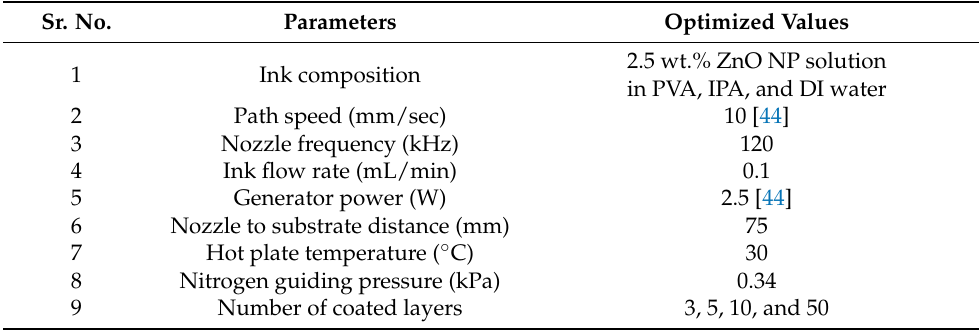
Table 1. The optimized parameters of the ultrasonic spray-coater. PVA, polyvinyl alcohol; IPA isopropyl alcohol; DI, deionized. Sr. No.